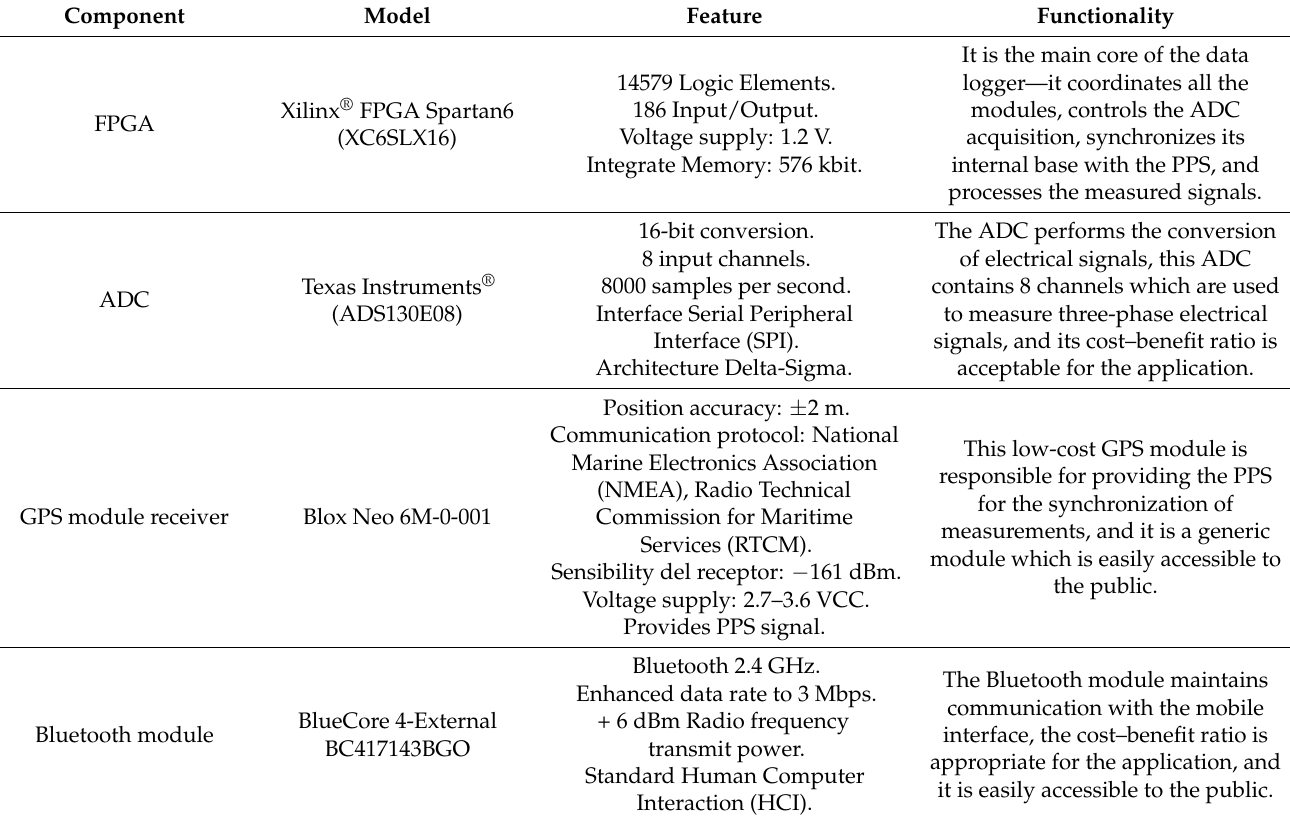
Table 1. Proprietary data logger hardware technical